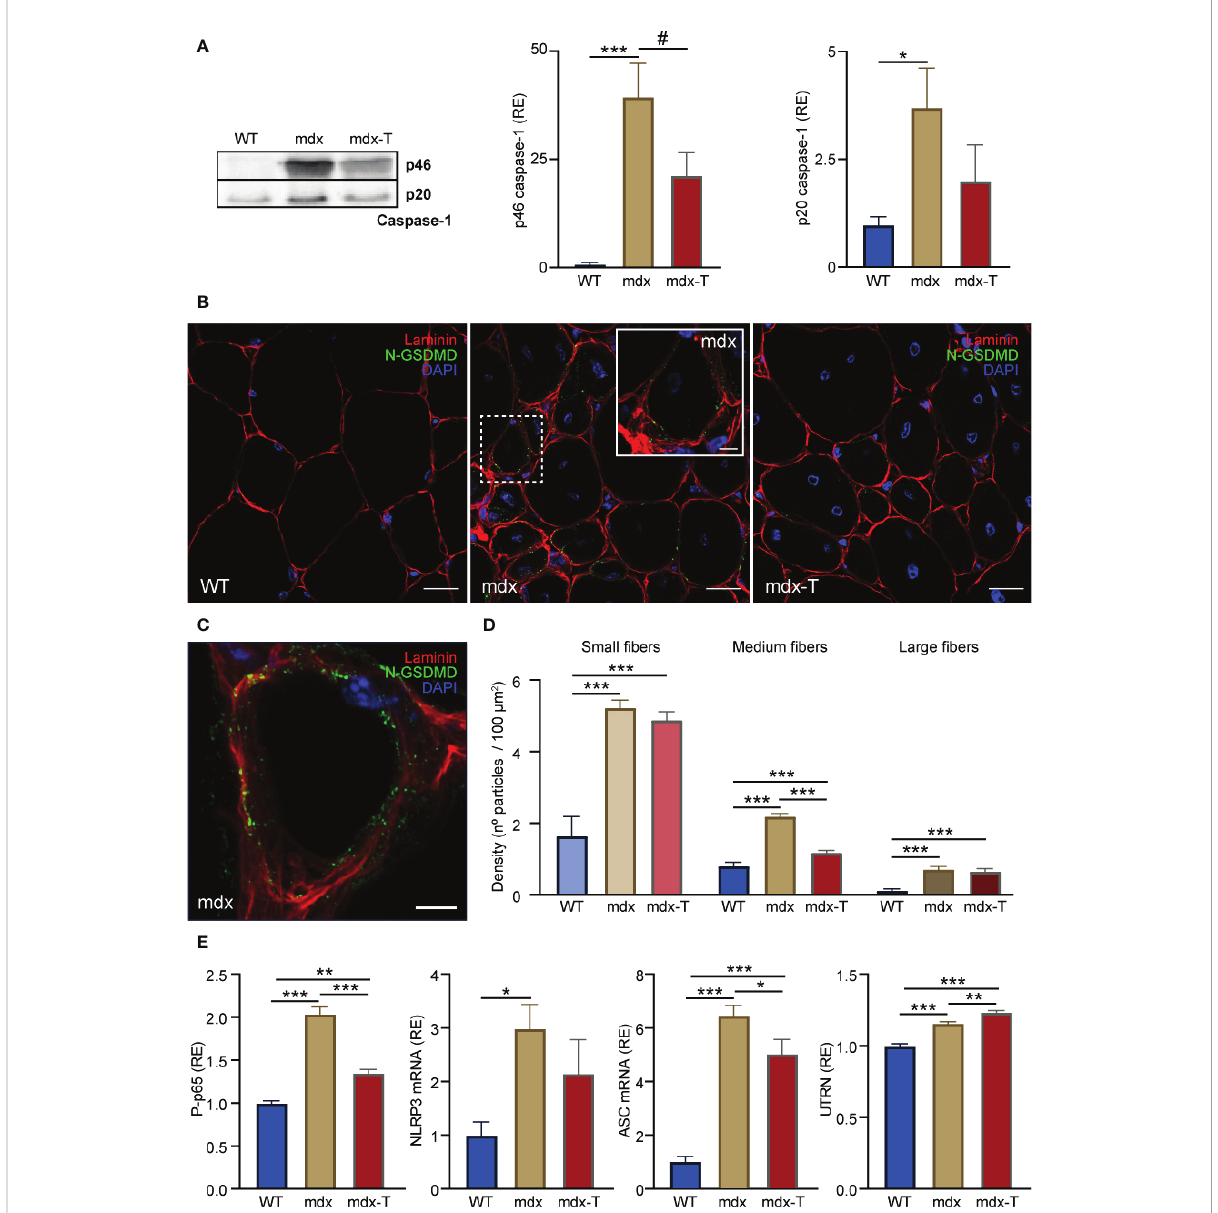
FIGURE 6 MCC950 treatment disrupts pyroptosis and increases the levels of a dystrophin analogue in mdx mice. Experiments were performed on Q from the three groups of mice. (A) Caspase-1 analysis by Western blotting. Levels of each marker (full-length p46 and cleaved p20 subunit) were normalized to Ponceau (shown in Figure S1) and expressed relative to WT values. (B) Distribution of N-GSDMD density by immuno fl uorescence labelling. Sections were stained with speci fi c antibodies directed against N-GSDMD (green) and laminin (red) and co-stained with DAPI (blue). The inset (dashed white square) shows the labelling of N-GSDMD in a small-sized fi bre of a mdx untreated animal. (C) 3D reconstruction of a small mdx fi bre showing the distribution of N-GSDMD (green) close to the sarcolemma (laminin, red). Scale bars: B = 20 m m, inset on B = 5 m m, C = 5 m m. (D) N- GSDMD density (number of stained particles per 100 μm²) was quanti fi ed for each fi bre and presented according to fi bre size. (E) Levels of NF- k B activity, NLRP3 and ASC mRNAs, and UTRN protein. ELISAs were used to quantify the active phosphorylated form of the p65 subunit of NF- k B (P- p65) and UTRN. Absorbance data are presented as relative expression (RE) compared with WT values. mRNA levels were normalized to cyclophilin A, and the subsequent ratios presented as relative expression compared with WT. Data are expressed as means ± SEM; n = 6 mice per group for all experiments. Statistical analysis was performed using one ‐ way ANOVA followed by Tukey ’ s test. * P < 0.05, ** P < 0.01, *** P < 0.001 # P = 0.081 (A)